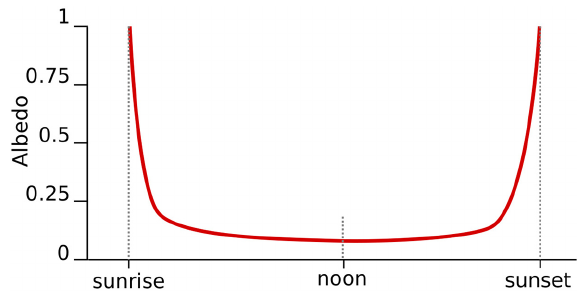
Fig. 1. The general Oren and Nayar (1995) model of the diurnal albedo